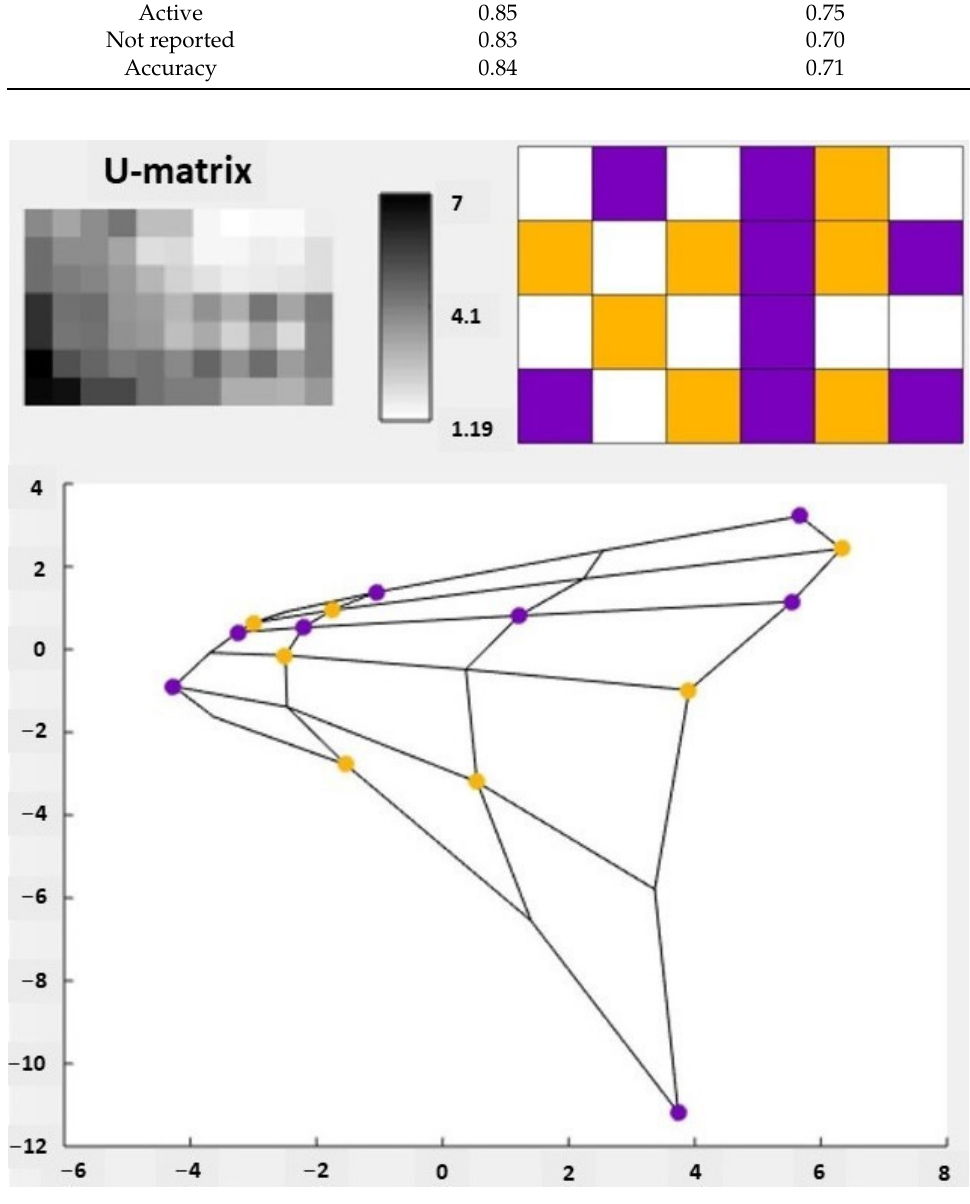
Figure 2. Visualization of the self-organizing map (SOM) of essential oil (EO) data. In the upper corner we have the U-matrix. The left U-matrix does not identify the activities of the EOs while the right U-matrix identifies those activities by color: active is violet and yellow represents samples with no antiprotozoal activity or that have not been reported. The values shown on the scale between the two U-matrices represent the values of the percent of molecules present in the EOs, varying between 1.19 and 7. These values were used to group the EOs by activities. At the bottom, we have the principal component analysis (PCA) projection of the SOM measured by its two eigenvectors with higher eigenvalues. The activities were plotted using the same identification colors as the